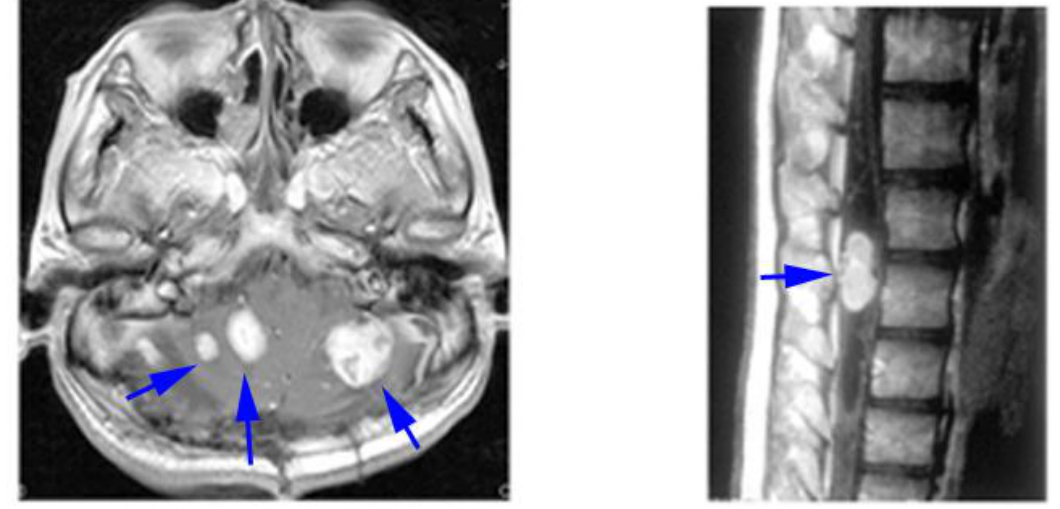
Figure 2. Contrast-enhanced T1 weighted MRI of CNS HBs in VHL. Left, multi-cerebellar HBs; right, lumbar spinal cord HB with